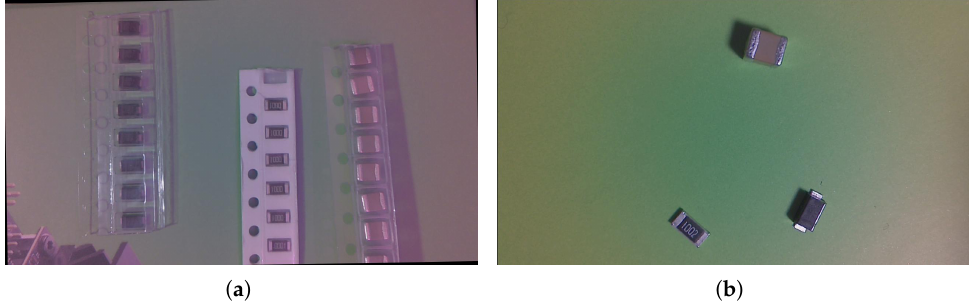
Figure 4. Sample images of a collected dataset with SMD components. ( a ) SMD components in a package. ( b ) SMD components without a